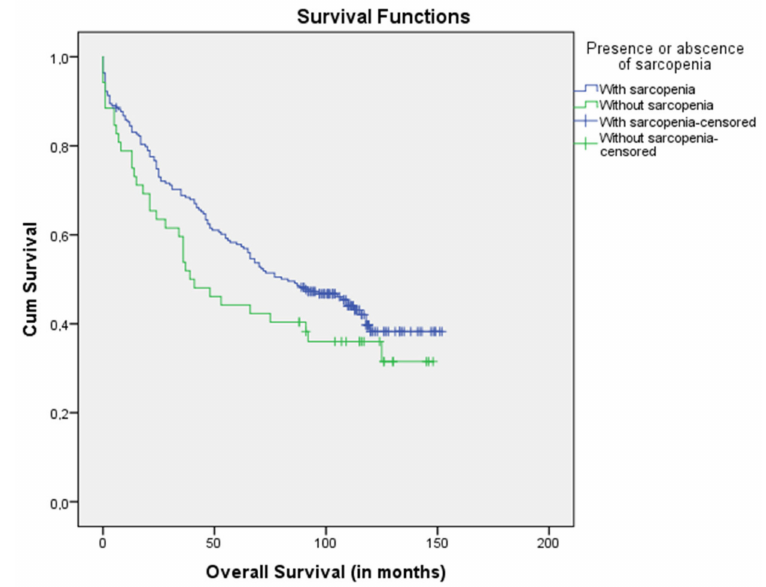
Figure 1. Overall survival in sarcopenic and non-sarcopenic patients (in months). p =